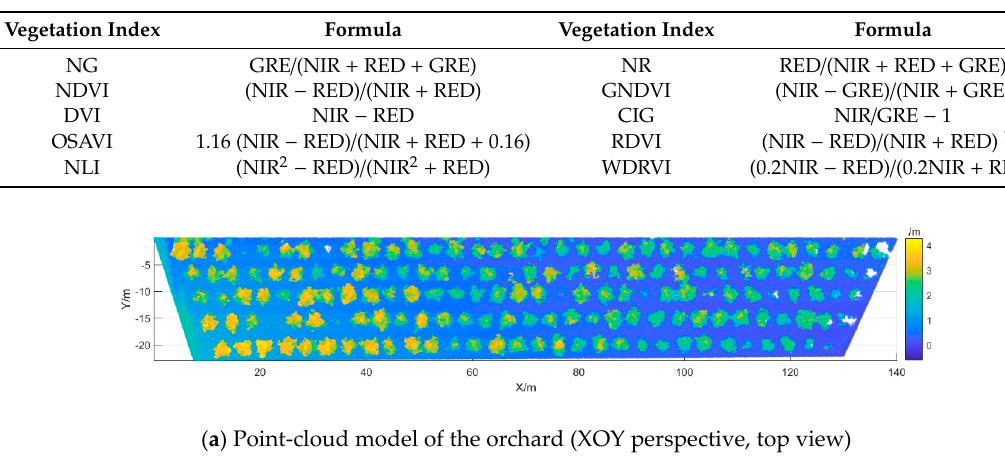
Table 3. Vegetation indices and their calculation formulas.